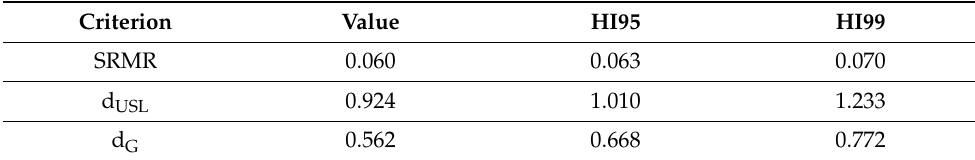
Table 1. Global model fit measures.